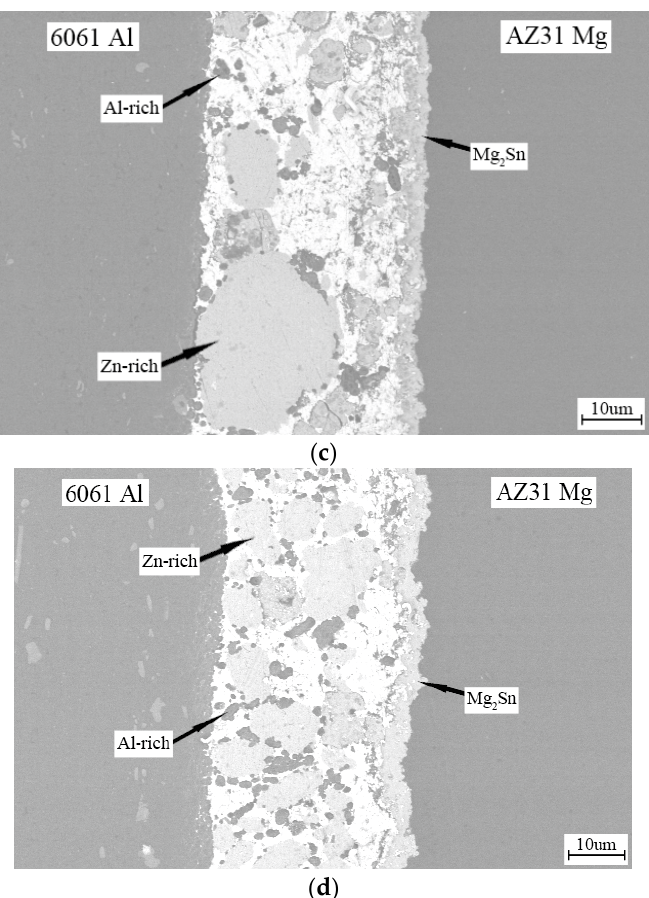
Figure 2. Cross-sectional SEM micrographs of the AZ31 magnesium/6061 aluminum alloy joints bonded with Sn-xZn-0.1RE filler metals. ( a ) Sn-5Zn-0.1RE, ( b ) Sn-10Zn-0.1RE, ( c ) Sn-20Zn-0.1RE, and ( d ) Sn-30Zn-0.1RE.